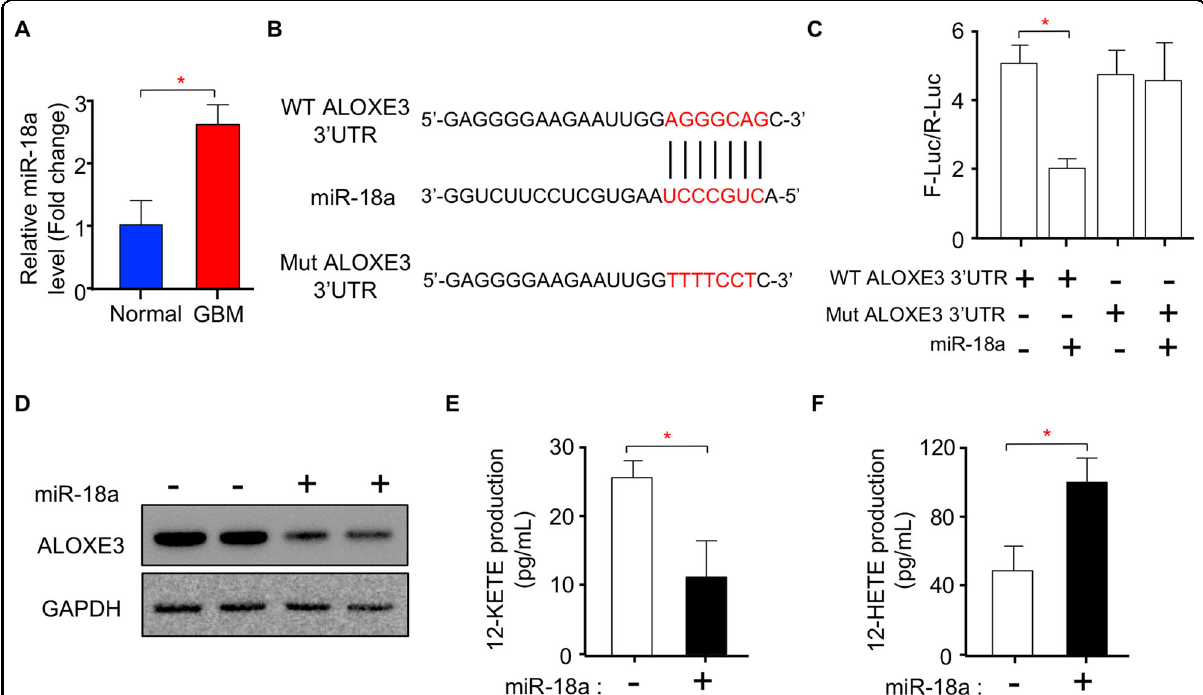
Fig. 5 miR-18a directly targets ALOXE3 and suppresses its expression in GBM cells. A Relative miR-18a level normalized with U6 in human GBM tissues and normal brain tissues ( n = 6). B Target sequence of miR-18a in the wildtype (WT) ALOXE3 3 ’ UTR and sequence of mutated (Mut) ALOXE3 3 ′ UTR. C Measurement of fi re fl y-luciferase activity normalized with the renilla-luciferase activity in U87 cells ( n = 6). D Immunoblotting analysis of ALOXE3 and GAPDH in U87 cells with miR-18a mimic or mimic-negative control treatment. Representative immunoblot images are shown ( n = 6). E-F Levels of ( E ) 12-KETE and ( F ) 12-HETE in culture medium harvested from U87 cells with miR-18a or mimic-negative control treatment ( n = 6). All data are represented as the mean ± s.e.m. * p < 0.05 (Student ’ s